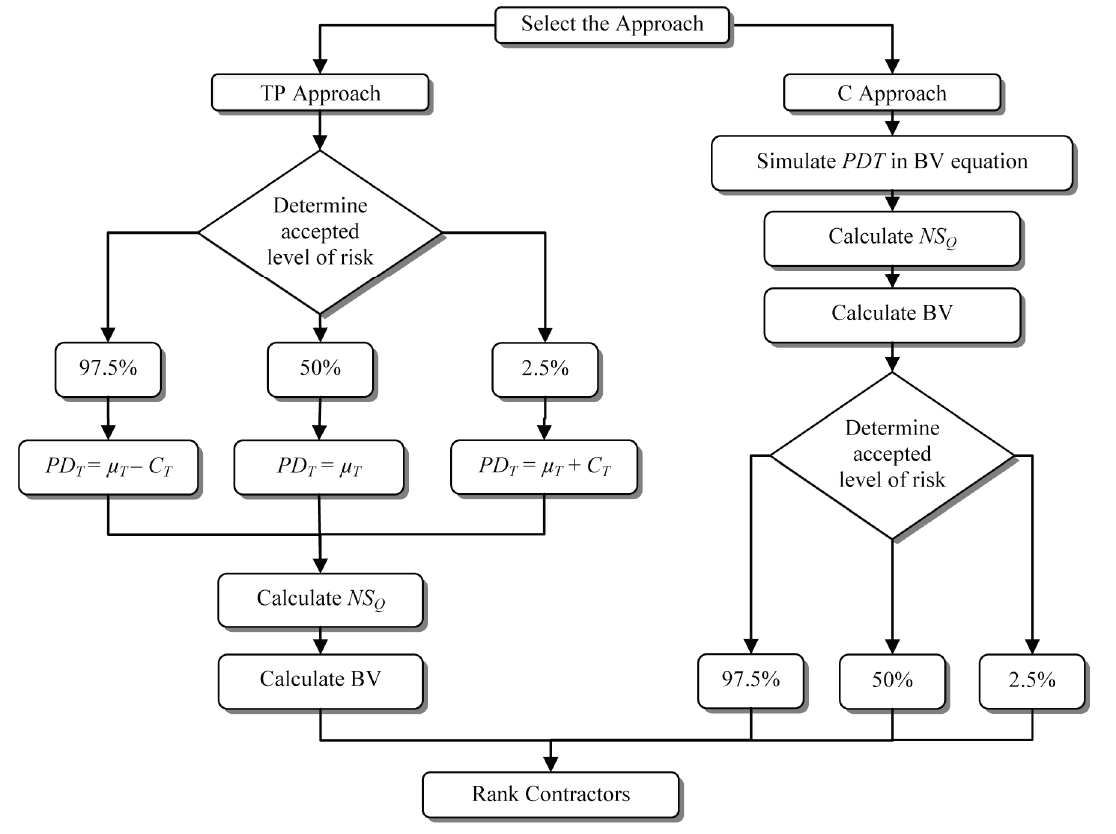
Fig. 3. Contractor Selection Algorithm